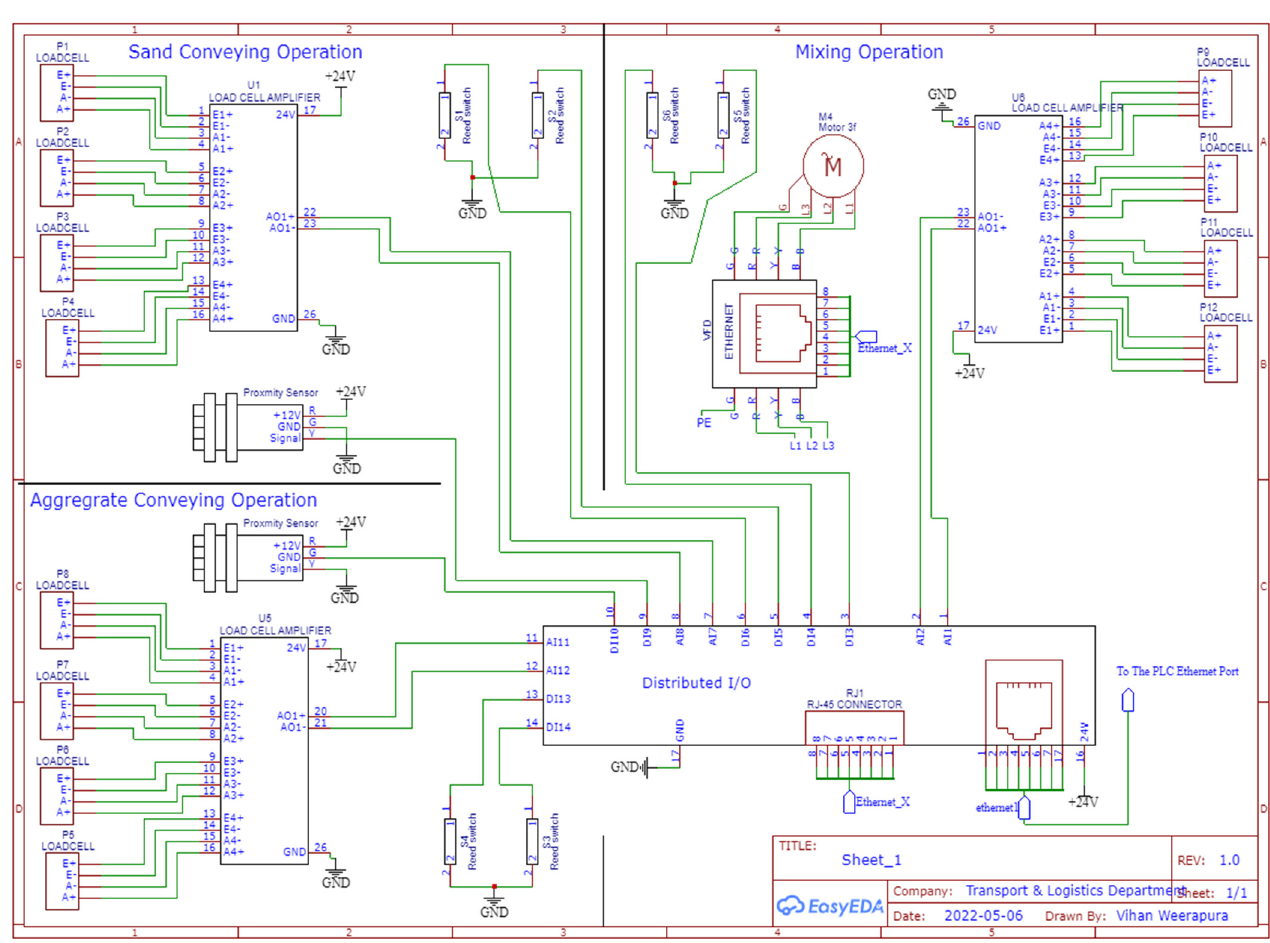
Figure 13. IoT Electrical Schematic Diagram Part 1.